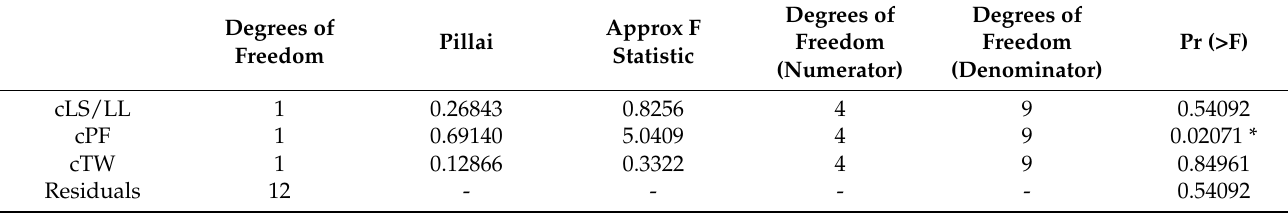
Table 7. Correlation matrix of variables and principal